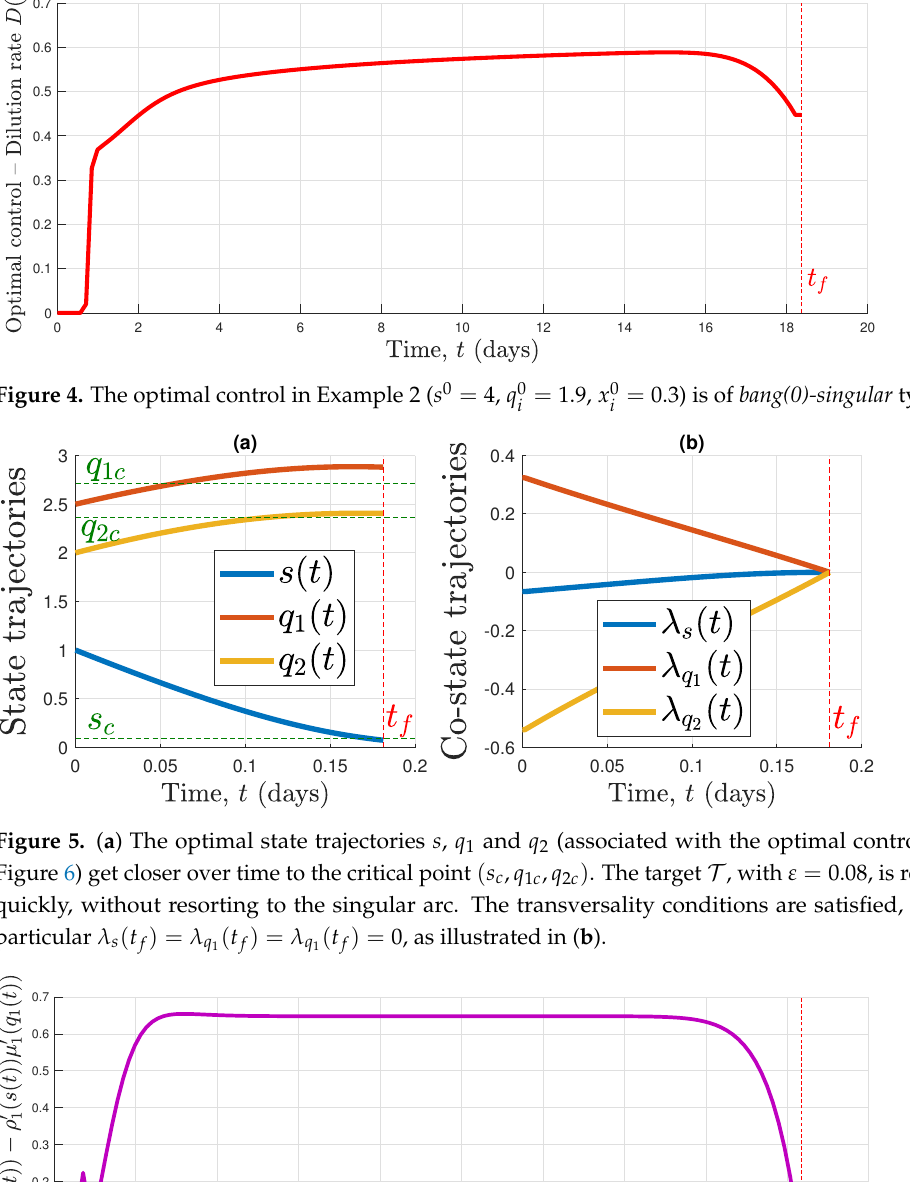
Figure 6. Evolution of the quantity ρ (cid:48) ries given in Figure